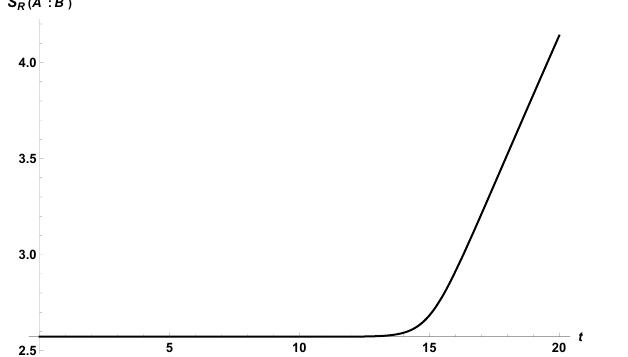
Figure 15. Page curve for the reflected entropy between two fixed adjacent intervals A = [0 , 15] and B = [15 , 30] in a escaping mirror BCFT 2 ; β = 0 . 5 , S bdy = 0 . 2 , c = 1